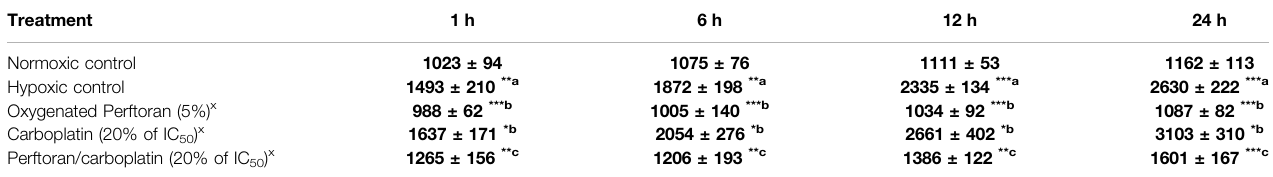
TABLE 3 | Evaluation of the total hypoxia/pimonidazole adducts, in A549 cells. Cells were seeded under variable treatments and conditions for different incubation intervals (1, 6, 12, and 24 h). The fl uorescence readings of pimonidazole adducts are presented RFU ( n = 8). Results are expressed as mean ± standard error.